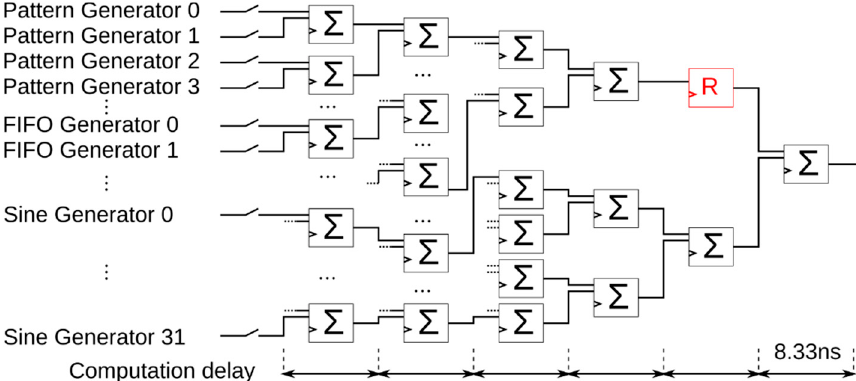
Figure 8. Architecture of the adder tree combining the WGs outputs. In this example the WGs are a series of Pattern Generators, FIFO Generators and Sine Generators. The simple register R marked in red is present for the unique purpose of balancing computation delays and keeping time coherence among added signals, whatever the original WG is. The total computation delay is 50 ns (8.33 ns for each single adder).